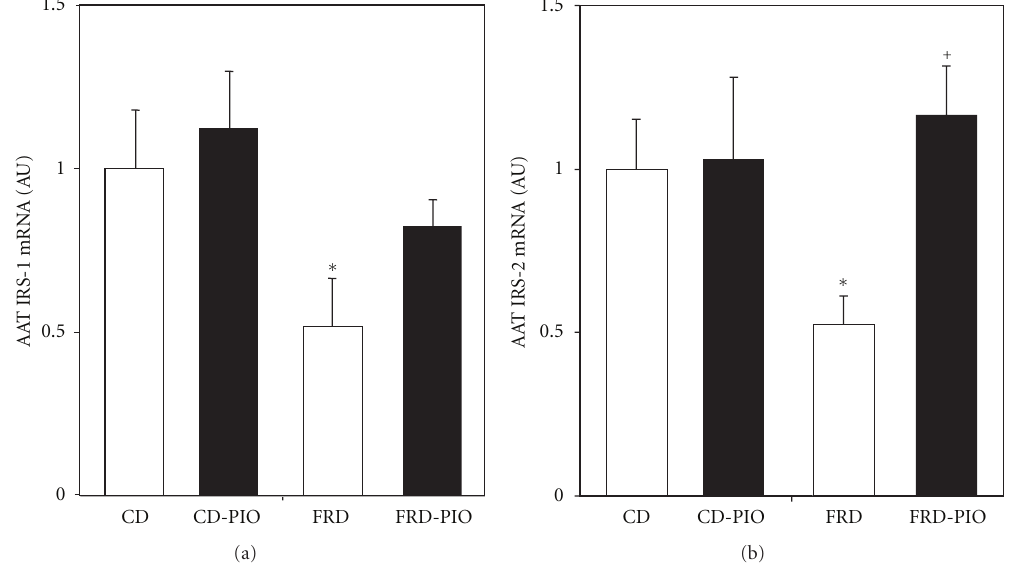
Figure 4: AAT IRS-1 (a) and IRS-2 (b) mRNA expression in pads from CD and FRD rats without or with PIO treatment. Data (expressed in arbitrary units: AU) were normalized to the levels of ACTB, and then presented as relative to values obtained in fat pads from CD rats. Means ± SEM ( n = 5/6 pads per group). ∗ P < 0.05 versus CD; + P < 0.05 versus